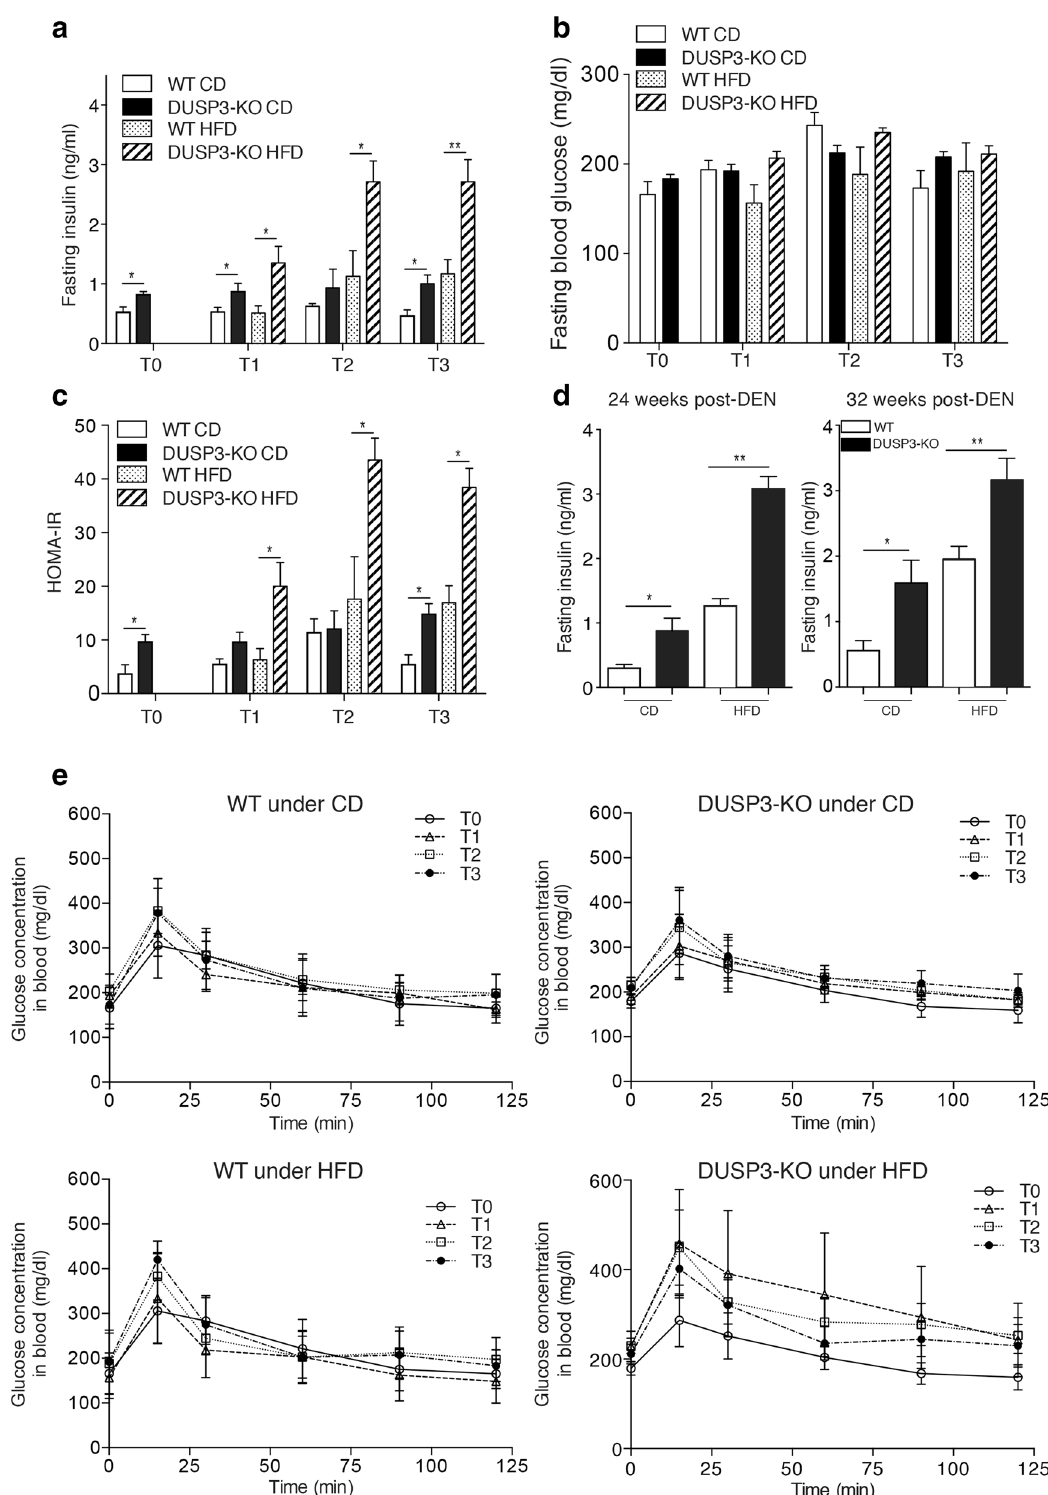
Figure 6. DUSP3 deletion exacerbate insulin resistance under HFD. Fasting blood insulin ( a ), blood glucose ( b ) and HOMA-IR ( c ) in DUSP3-KO and WT mice under CD or HFD. At all-time points, mice were starved for 6 h and blood was collected from tail vein to measure insulin and glucose. T0, basal level, corresponds to the measurement at the starting day of HFD. T1, T2 and T3 correspond respectively to 4 weeks, 12 weeks and 20 weeks under HFD or CD. N = 5 mice in each group of T1 to T3. N = 10 mice in each group at T0. ( d ) Fasting blood insulin in 24 weeks (left panel) and 32 weeks (right panel) after DEN challenge of DUSP3-KO and WT mice under CD or HFD. N = 5 mice in each group. Data represent means ± SD. Significance was determined by one-way